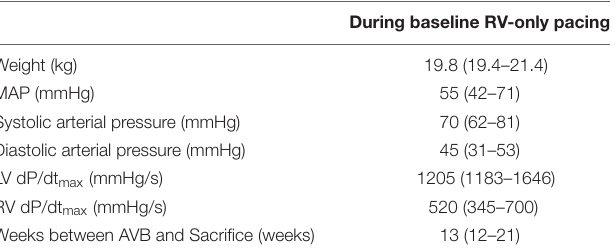
TABLE 1 | Baseline characteristics in median (range) of dogs during baseline (RV-only, A-RV 125 ms pacing). During baseline RV-only